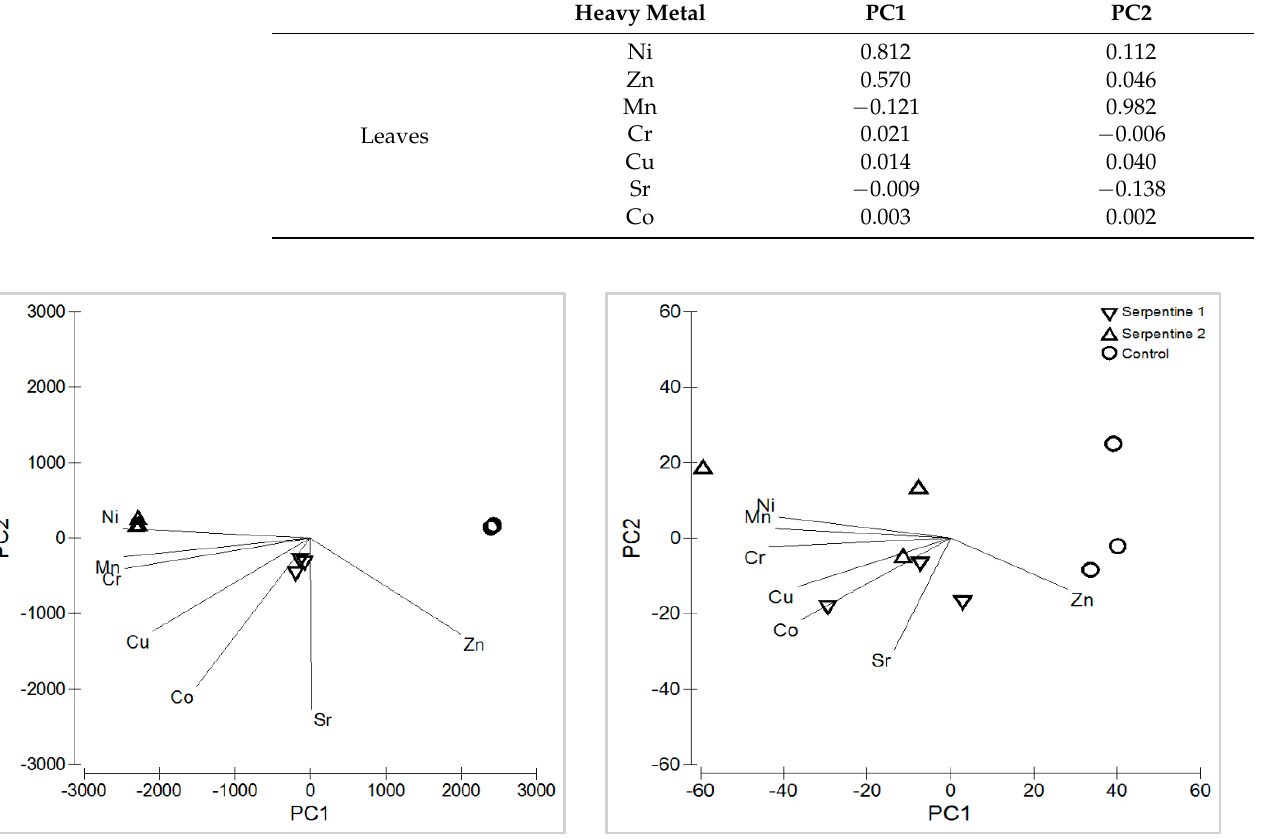
Figure 2. Principal component analysis of heavy metals in soil ( left ) and B. radula leaves ( right ), for the study treatments.